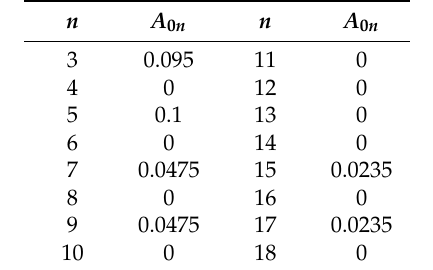
Table 1. The amplitude of baseband harmonics in the output